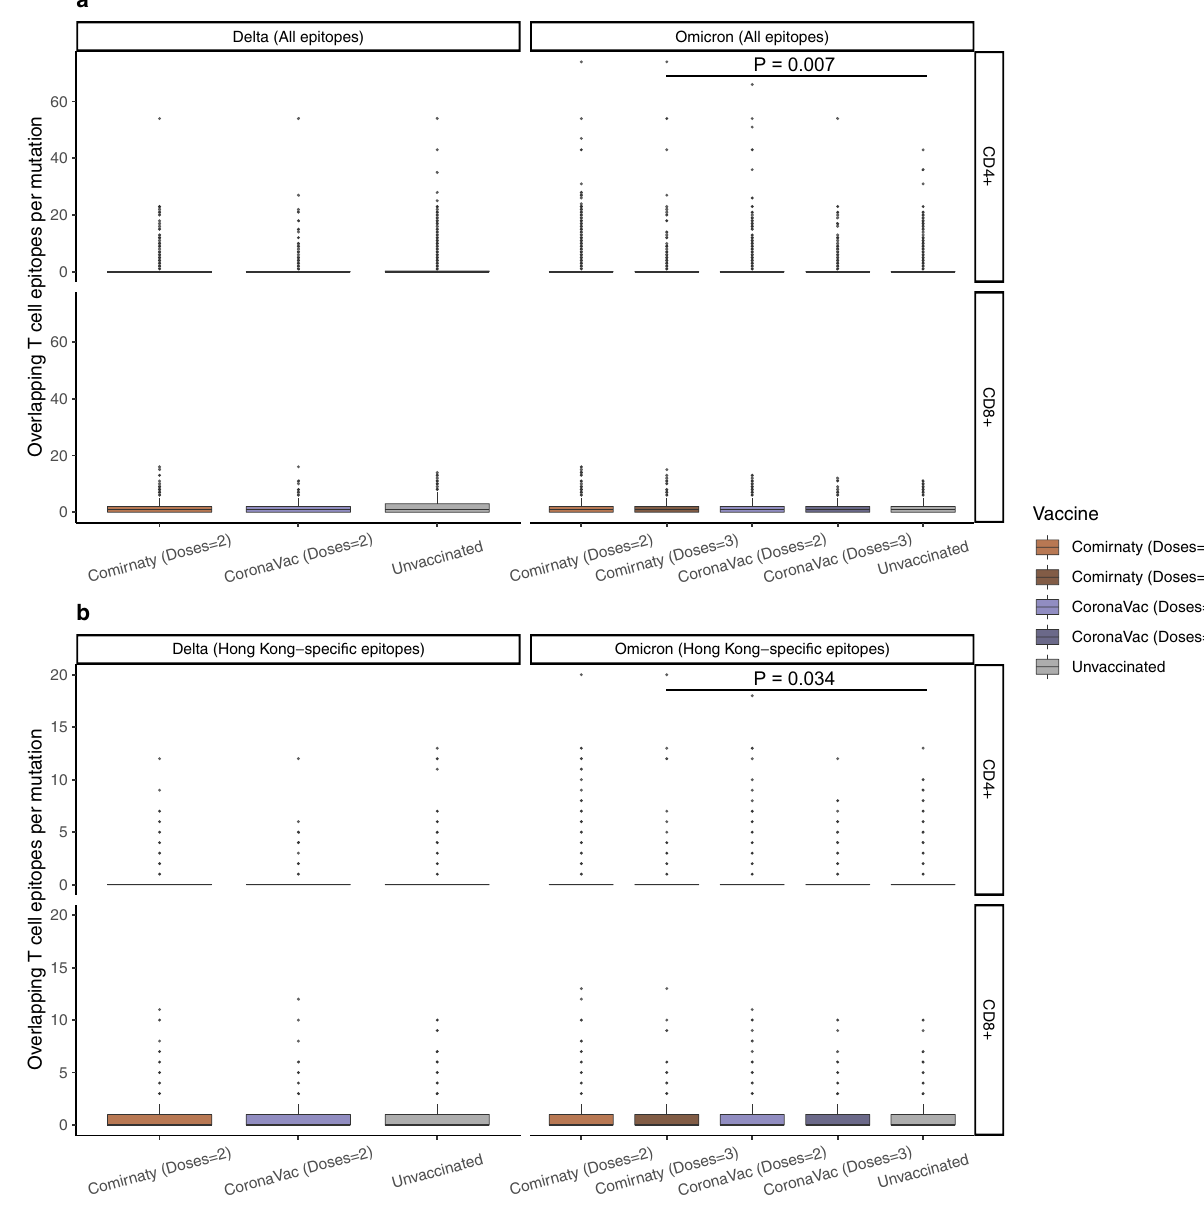
Fig. 5 | Overlapping known SARS-CoV-2 CD8 + and CD4 + T cell epitopes per mutation in unvaccinated and vaccinated Delta and Omicron samples. a AnalysisbasedonallknownSARS-CoV-2Tcellepitopes. b AnalysisbasedonTcell epitopes associated with HLA alleles prevalent in the Hong Kong population. Pairwise comparisons within groups were performed by the two-sided two-sample